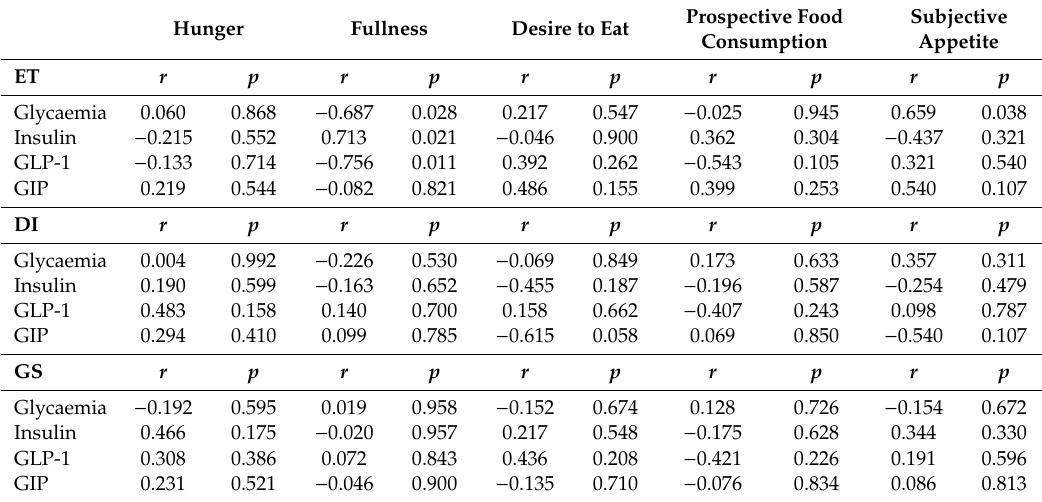
Table 6. Coe ffi cient correlations between AUC values of glycaemia, EIAP and subjective measurements of appetite according to consumption tests. Hunger Fullness Desire to Eat